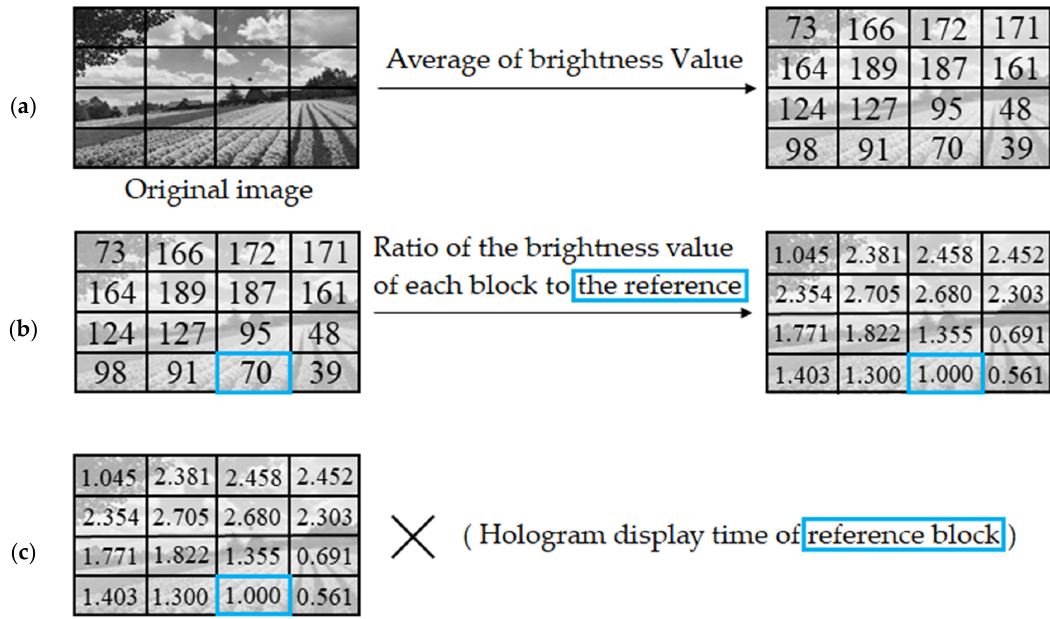
Figure 7. Calculation of projection time: ( a ) calculate the average brightness value, ( b ) calculate the ratio of the average values relative to the reference, and ( c ) calculate the projection times for each division block. The blue rectangle indicates the reference block.